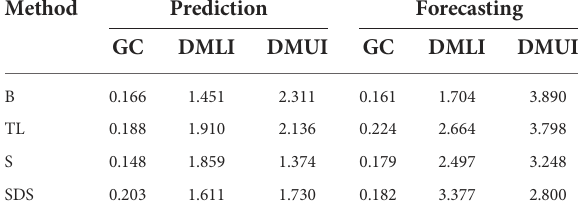
TABLE 5 Individual-level fairness captured by the Gini Coef fi cient (GC), Distance-to-Median Lower Index (DMLI), and Distance-to- Median Upper Index (DMUI). GC serves as a coarse marker of inequality, with DMLI and DMUI further elucidating whether the bene fi ts are reaped by those in the lower or upper end of individual- level